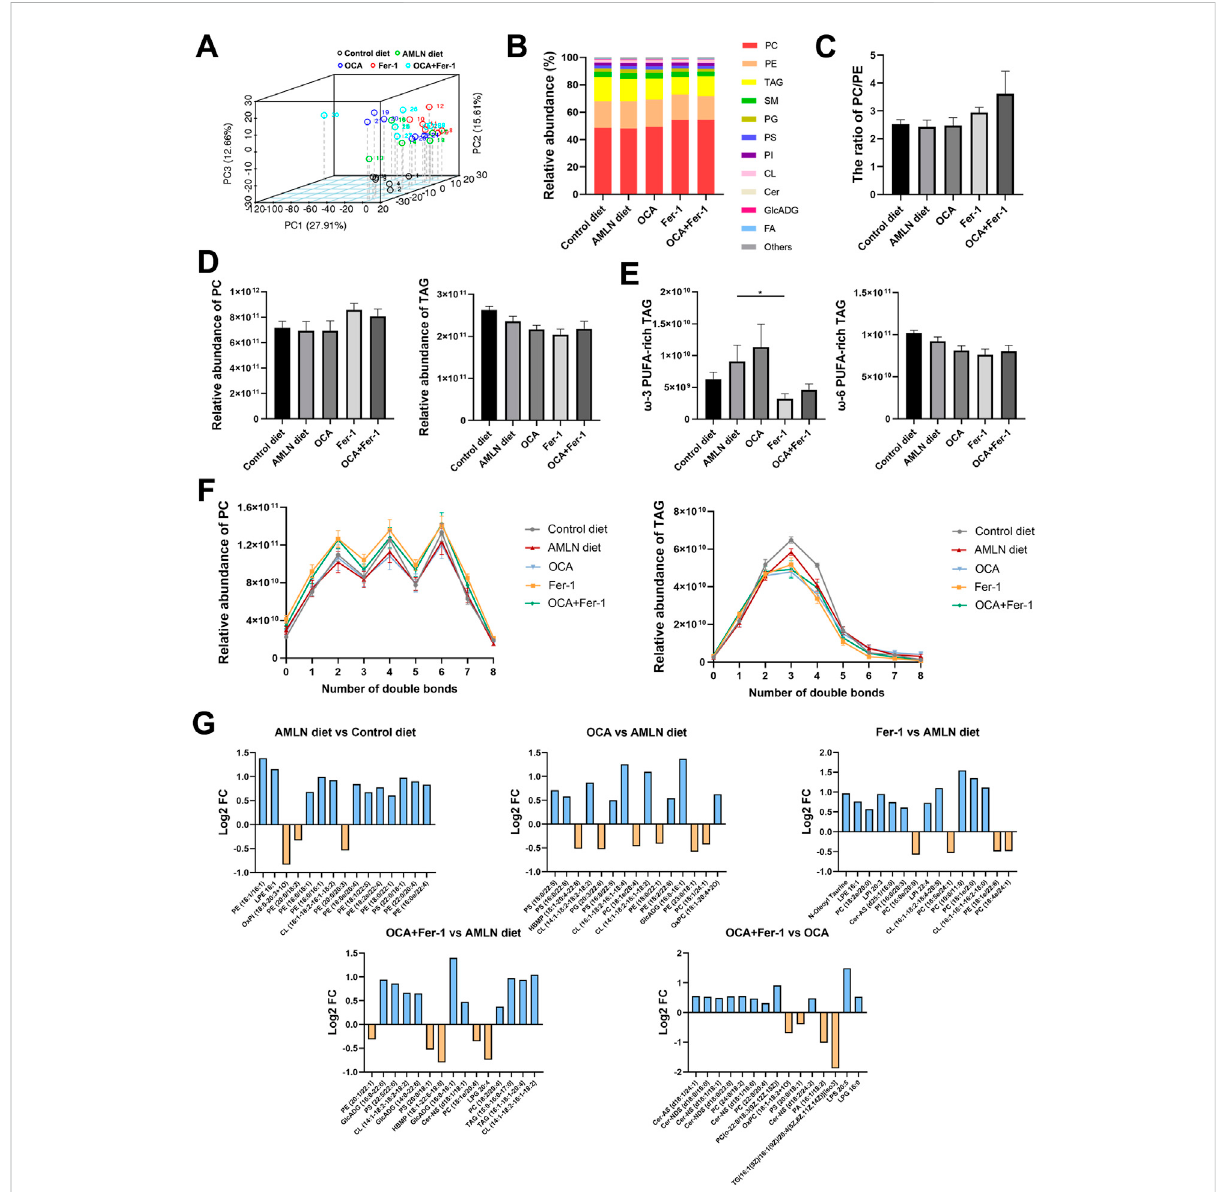
OCAandFer-1differentiallymodulatedhepaticlipidome. (A) PrincipalComponentAnalysisbetweenthe fi vegroups. (B) Relativeabundance(%) of lipid subclass among fi ve groups (C) The ratio of PC/PE. (D) Relative abundance of PC (left) and TAG (right). (E) Relative abundance of ω -3 PUFA -richTAG (left)and ω -6PUFA-richTAG (right). (F) Relative abundanceofPC(left)andTAG (right)withdifferentamount ofdoublebonds. (G) The top 15 most signi fi cant lipids between groups. Data are shown as mean ± SEM. * p <